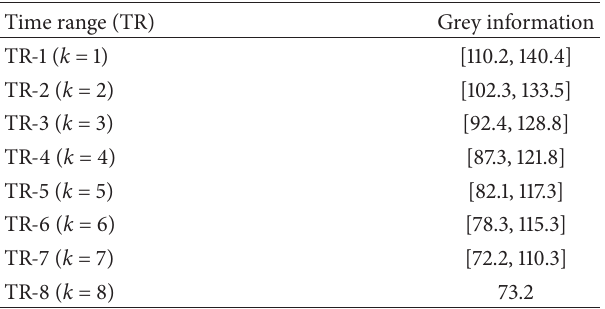
Table 1: Concentration of DDT in atmosphere of a certain city in southern China (ng ⋅ m −3